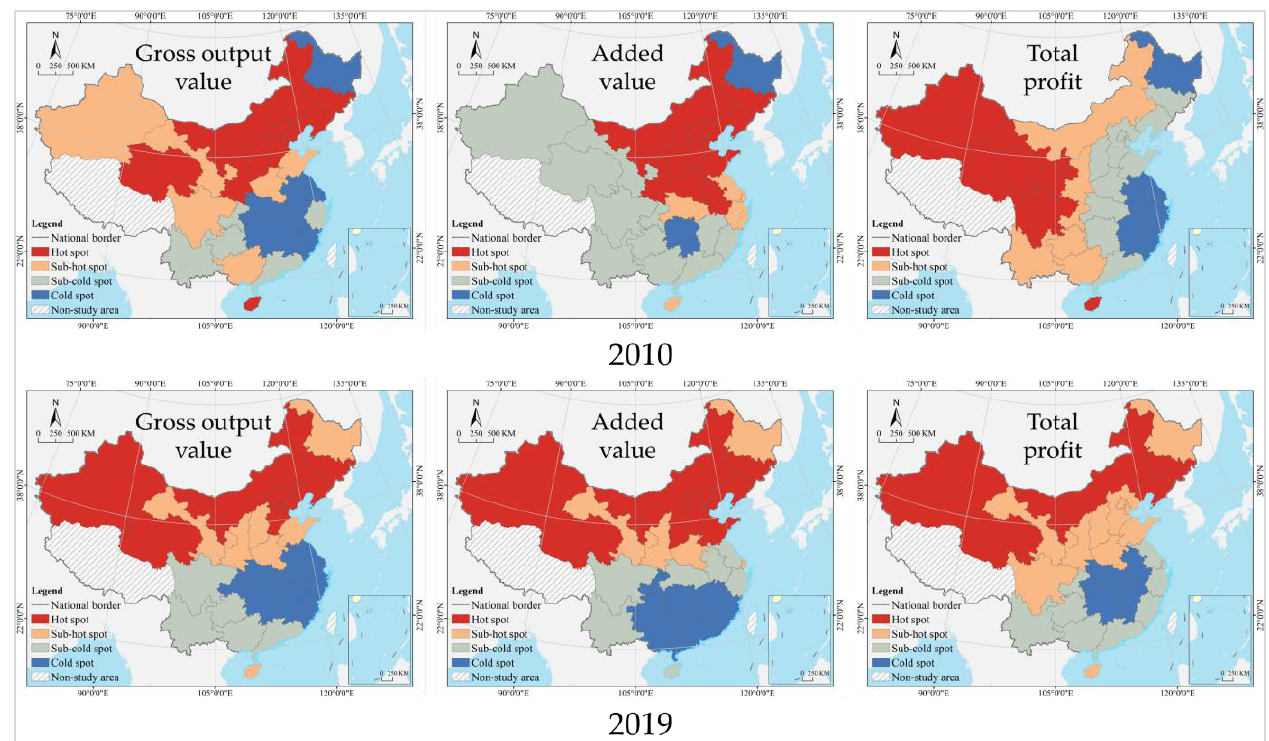
Figure 11. Spatial hot and cold spots of ECI in 2010 and 2019.